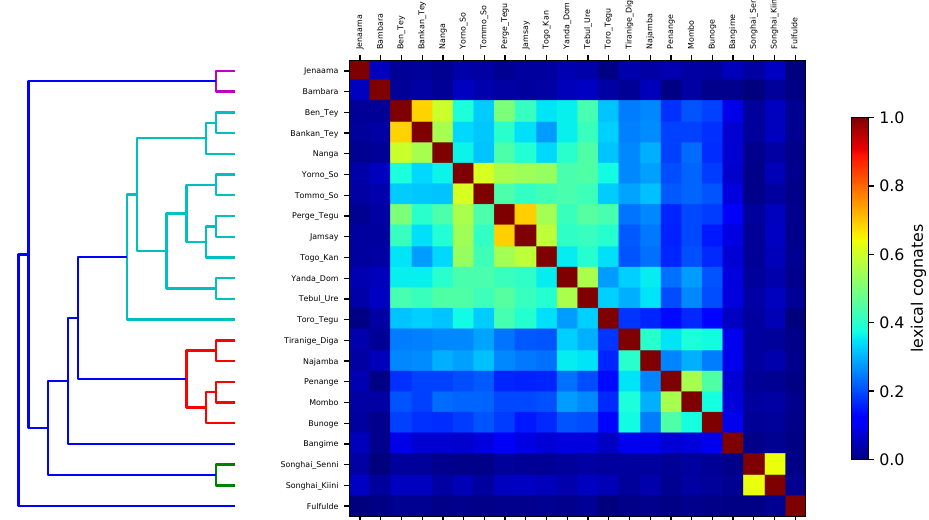
Figure 2: Heat Map generated from the cognate percentages inferred by the LexStat‑ Infomap approach. The cognates chosen by the LexStat‑Infomap approach which appear here as lighter colors on the spectrum towards red in the middle, where each language is compared with itself, can be interpreted either as true cognates or deeper levels of